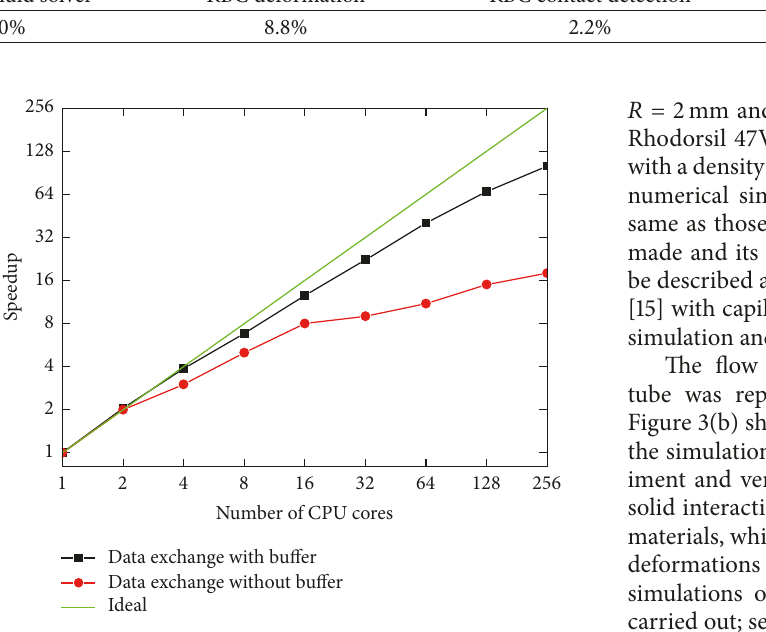
Figure 2: Speedup of the parallelized code with number of CPU